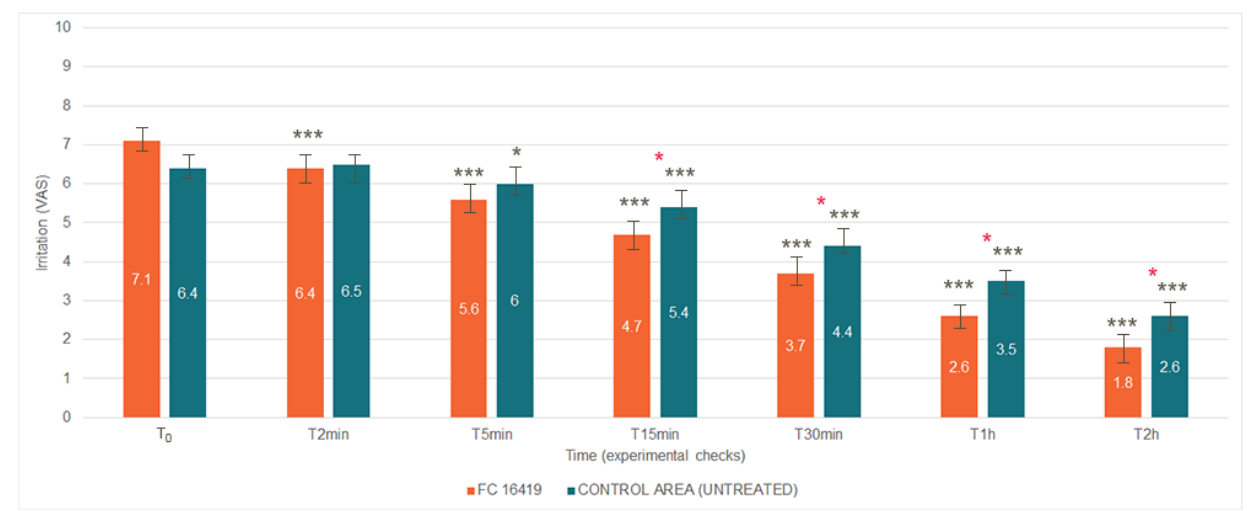
Figure 7. Evaluation of Irritation (VAS score) caused by bites after application of FC 16419 and on untreated bites (Data are reported as mean ± SEM). Black asterisks in the graph report the intra-group (vs. T 0 ) and the red asterisks the inter-group statistical analysis (vs. untreated). Legend (significance): *** p < 0.001; * p < 0.05.